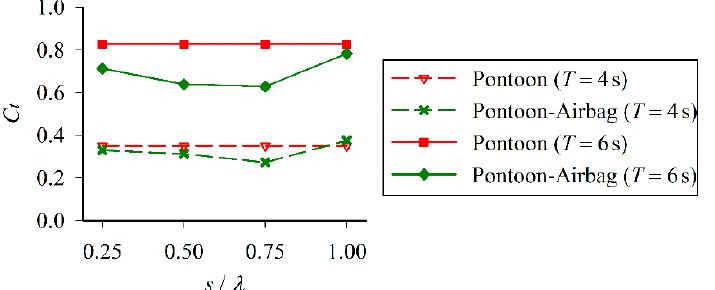
Figure 13. Comparison of the wave transmission coefficients C t of the double-row floating breakwater with different separation distance s / λ .